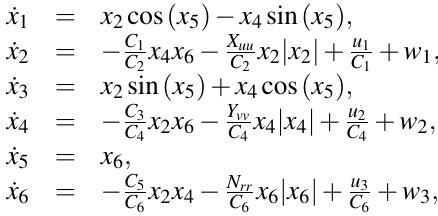
Table 4. Values of the parameters for U-CAT model Parameter Value